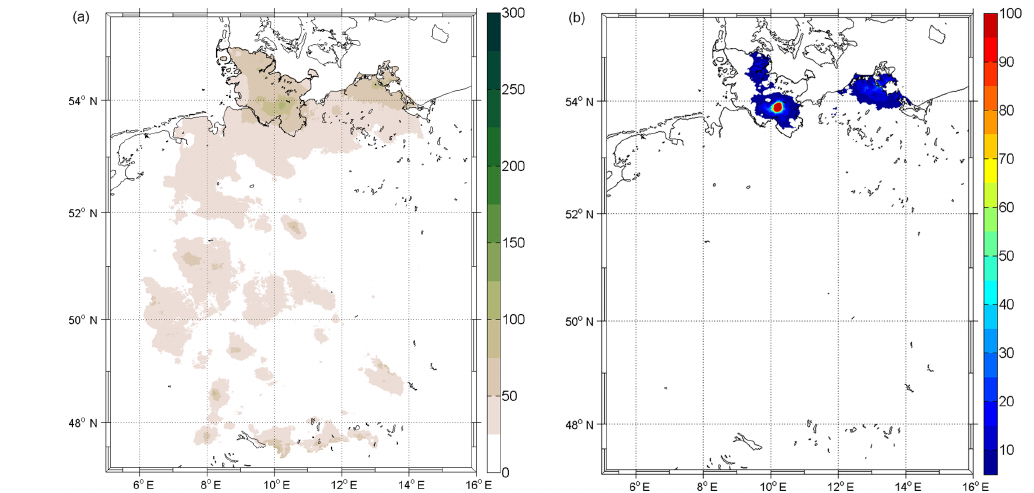
Figure 7. (a) Three-day event precipitation (R3d) in millimetres and (b) corresponding return periods (base period 1960–2009) for the De- cember 2014 flood in Schleswig-Holstein, Germany, calculated from REGNIE data following the method described in Schröter et al. (2015). The boundaries of Schleswig-Holstein are marked in